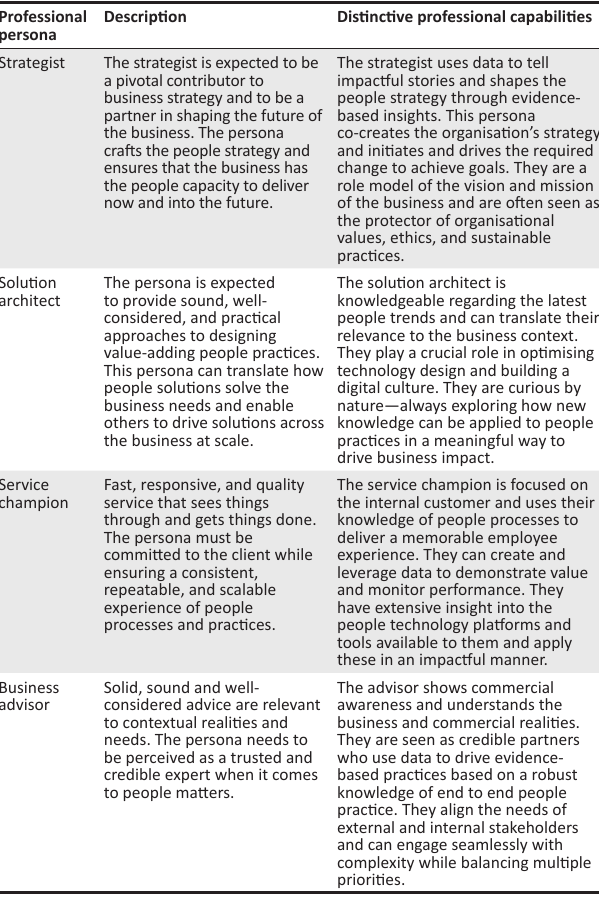
TABLE 3: The future-fit people practitioner professional personas and distinctive professional